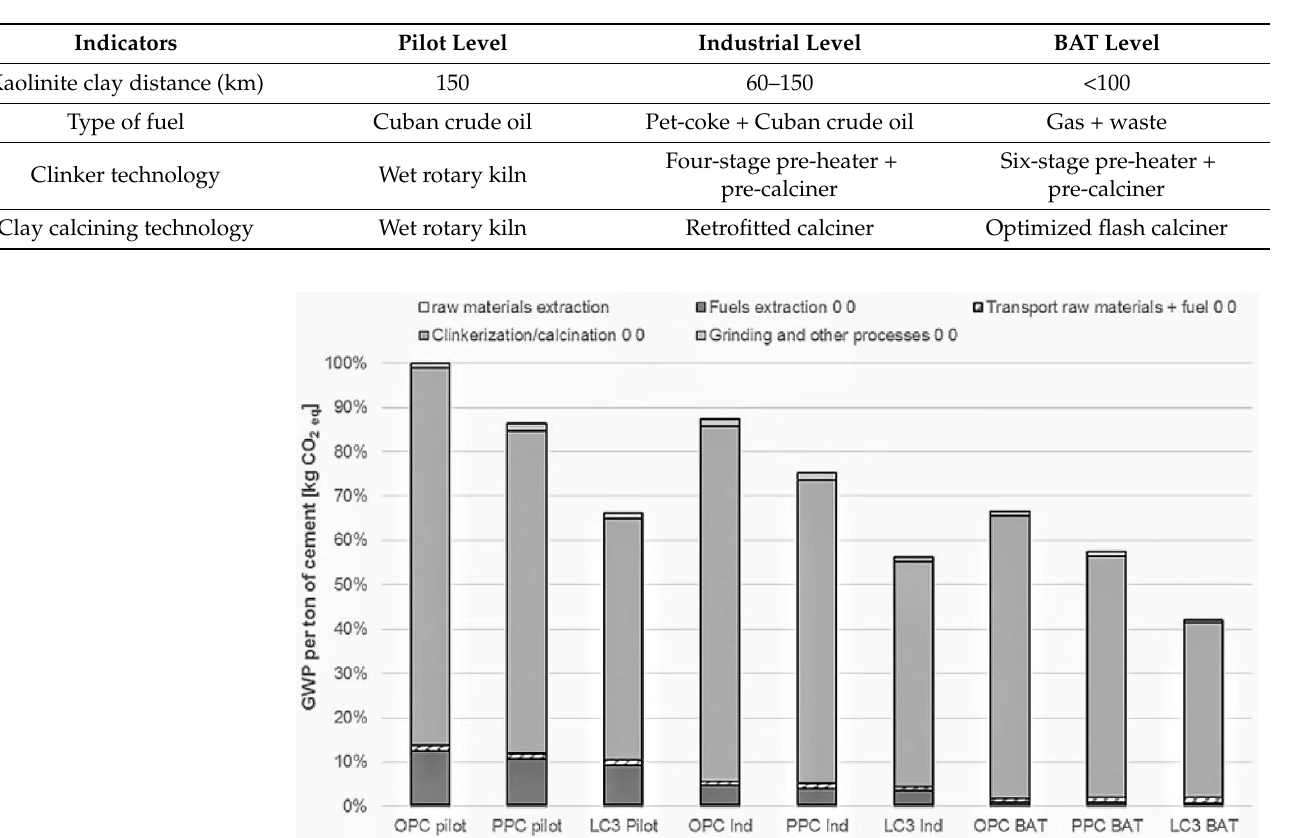
Figure 1. CO 2 emissions of LC3 in comparison with other cement. Reprinted with permission from Ref. [3]. Copyright: 2018, Karen Scrivener. Published by Elsevier. Table 1. Input data of different technologies in Cuban cement industry [3]. Reprinted with permission from Ref. [3]. Copyright: 2018, Karen Scrivener. Published by Elsevier.